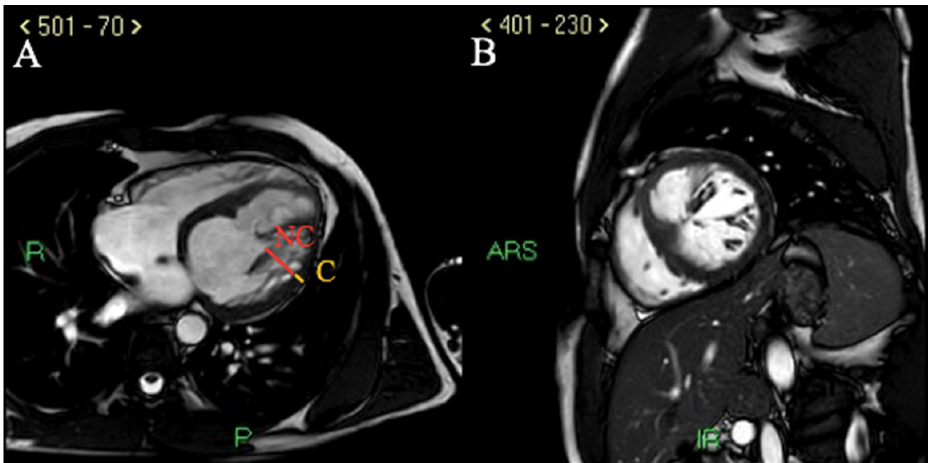
Figure 4. Cardiac MRI. ( A ) cine-steady state-free precession sequence (SSFP) showing an end diastolic NC/C ratio of 5 in long axis view, diagnostic for pathologic LVNC according to Petersen’s criteria. ( B ) cine-SSFP sequence showing non-compaction myocardial hypertrabecularization in end diastolic short axis view.